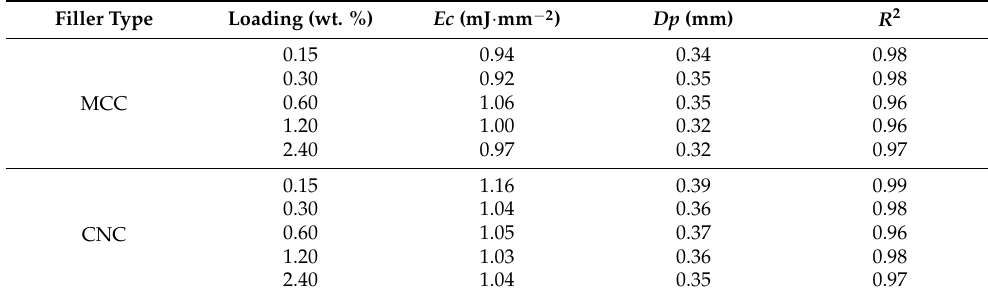
Table 9. Depth penetration ( Dp ) and critical energy ( Ec ) as a function of MCC and CNC loadings. Statistical analyses were performed using Pearson’s correlation for MCC and CNC with p <